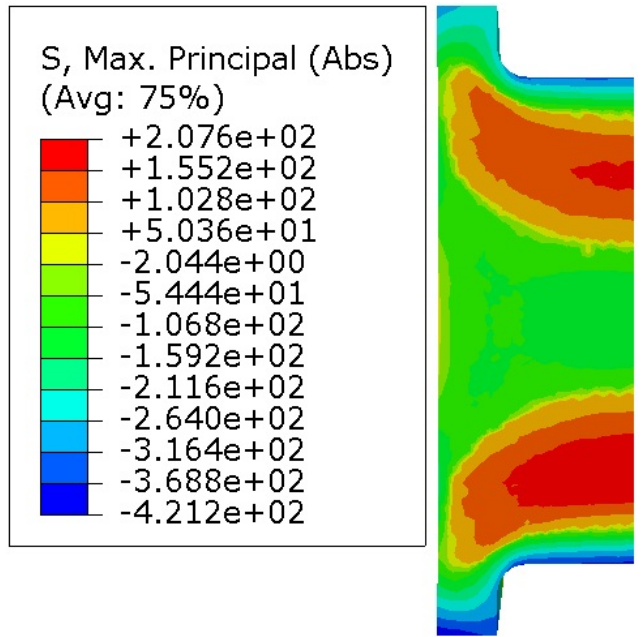
Figure 8. The residual stress field distribution of crankshaft N0.